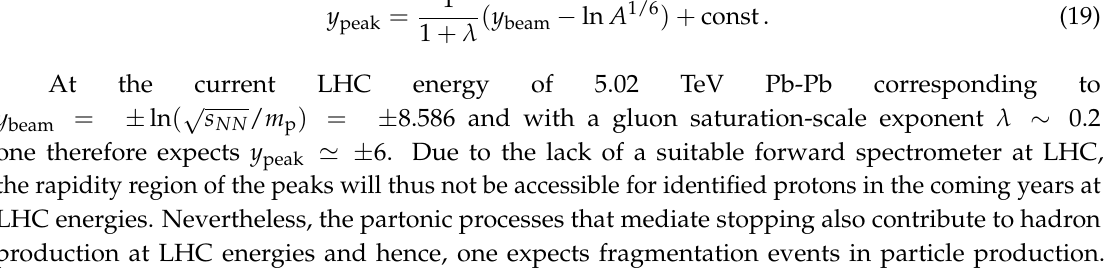
Figure 6. Rapidity distributions of net protons in central Pb-Pb collisions at SPS energies of = 17.3 GeV compared with NA49 data [35]. Red curves are the initial distributions broadened by the Fermi momentum, the final distribution is from our QCD-inspired model [13] with the saturation-scale = 0.09 GeV 2 (see text). It agrees with the data, and exponent λ = 0.2 and Q 2 0